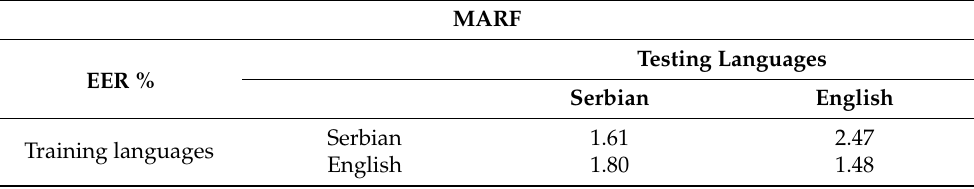
Table 3. The best MARF performance, as measured by EER, compared to the languages used.